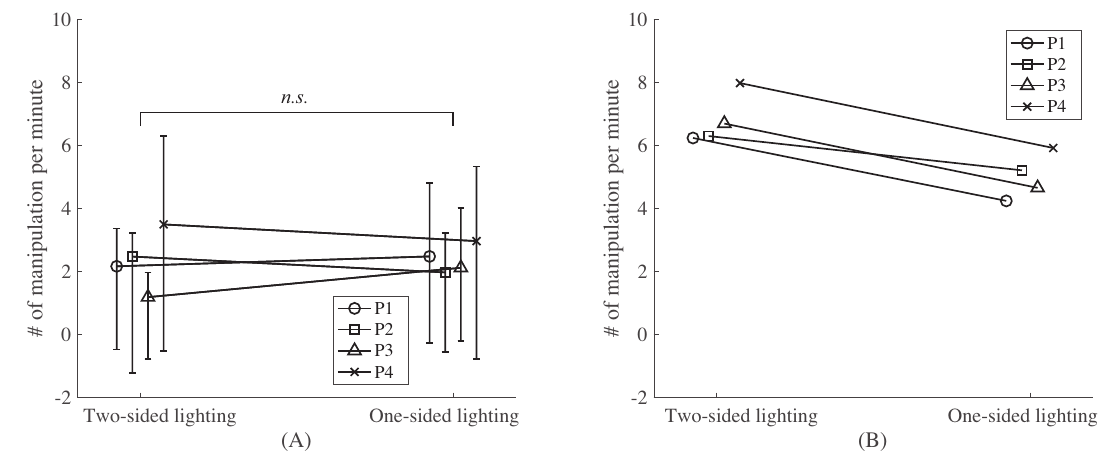
Figure 6. ( A ) Average and range of the number of toy manipulations counted by three coders (C1, C2 and C3), ( B ) Number of events detected by